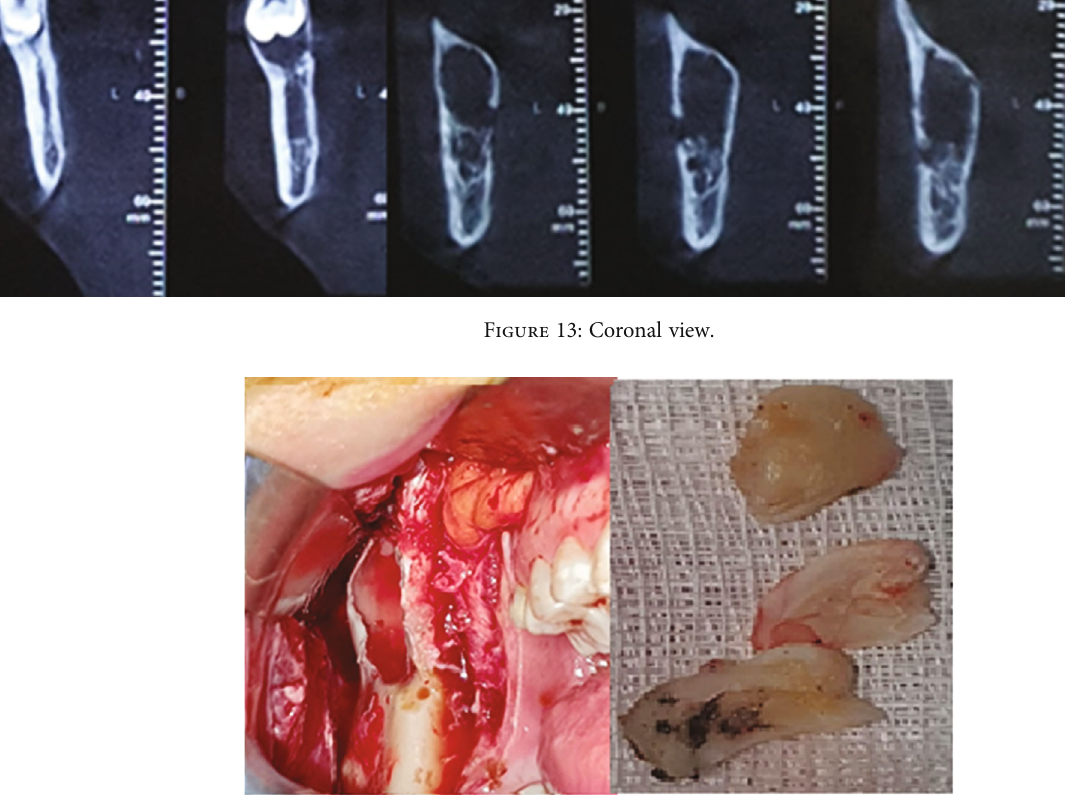
Figure 14: Exposed surgical region and removed tooth (three pieces).